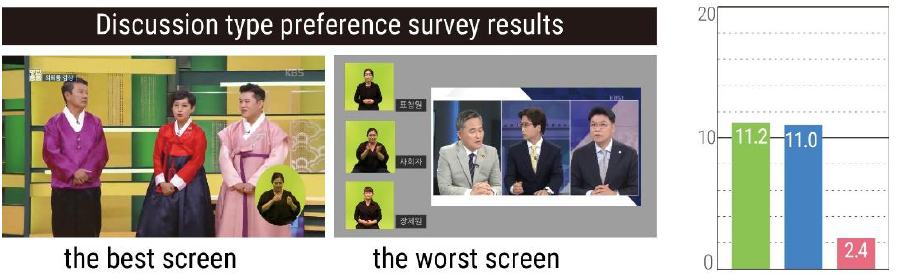
Figure 14. Results of preference evaluation with discussion cases.